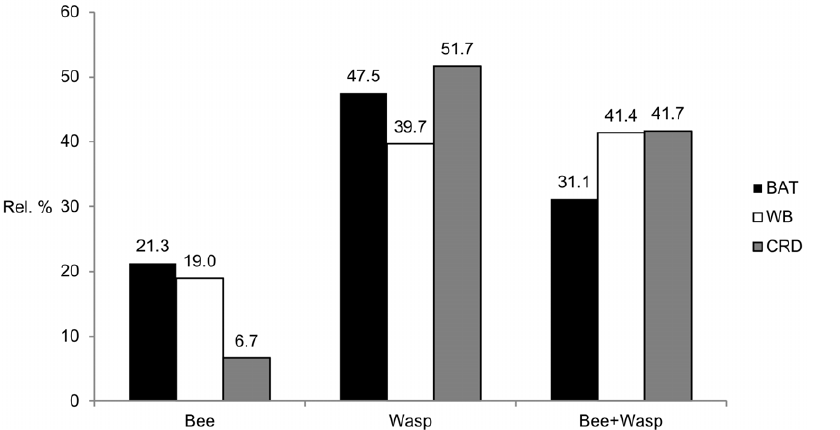
Figure 6. BAT results in relation to western blot inhibition and component resolved diagnosis. Although BAT was performed with native venom extracts, frequency of mono- and double sensitization was comparable with component based methods. Results of the BAT were in fair agreement with those of the CRD (60.0%, kappa 0.373, p , 0001) and WB (59.6%, kappa 0.377, p , 0001). Interestingly, the frequency of honey bee sensitization obtained with the CRD was markedly lower compared to BAT and WB, which could indicate a lower sensitivity of rApi m